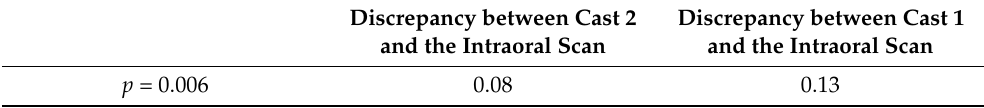
Table 1. The table shows mean values of discrepancies measured with the Hausdorff method (mm).